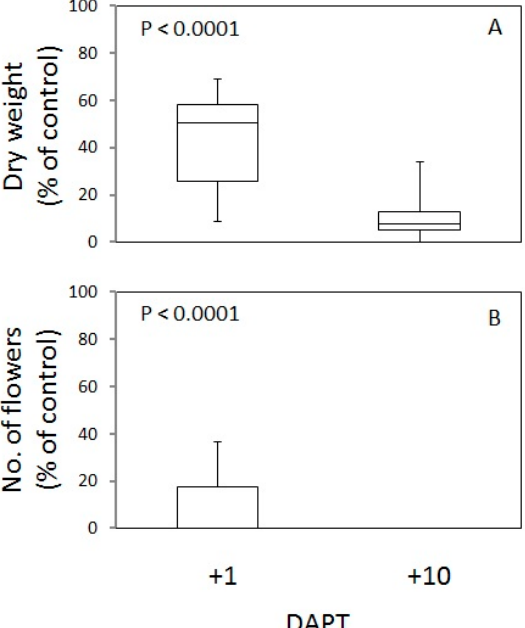
Figure 4. The impact of second treatment timing (1 or 10 days after previous treatment (DAPT)) on the above-ground dry weight ( A ) and the number of flowers ( B ) (% of control) of Ecballium elaterium. p- values were determined by Student's t-test. Values are mean ± SE ( n = 7).